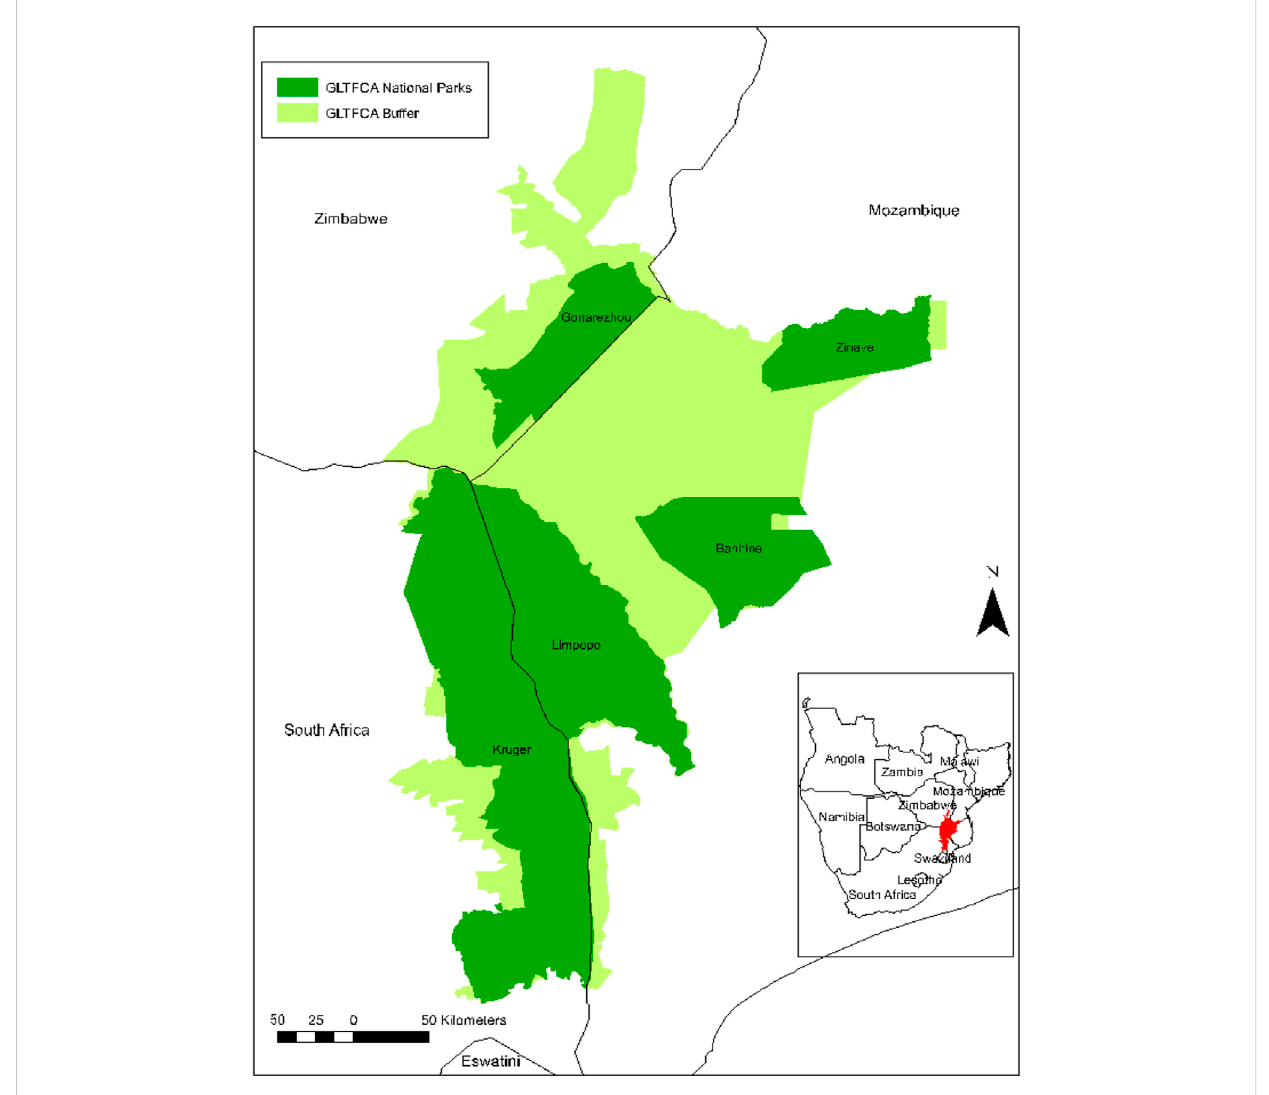
FIGURE 1 Study areamap ofthe fi veNationalParksandsurrounding Great Limpopo Transfrontier Conservation Area(GLTFCA)insouthern Africaacrossthree countries: South Africa, Mozambique, and